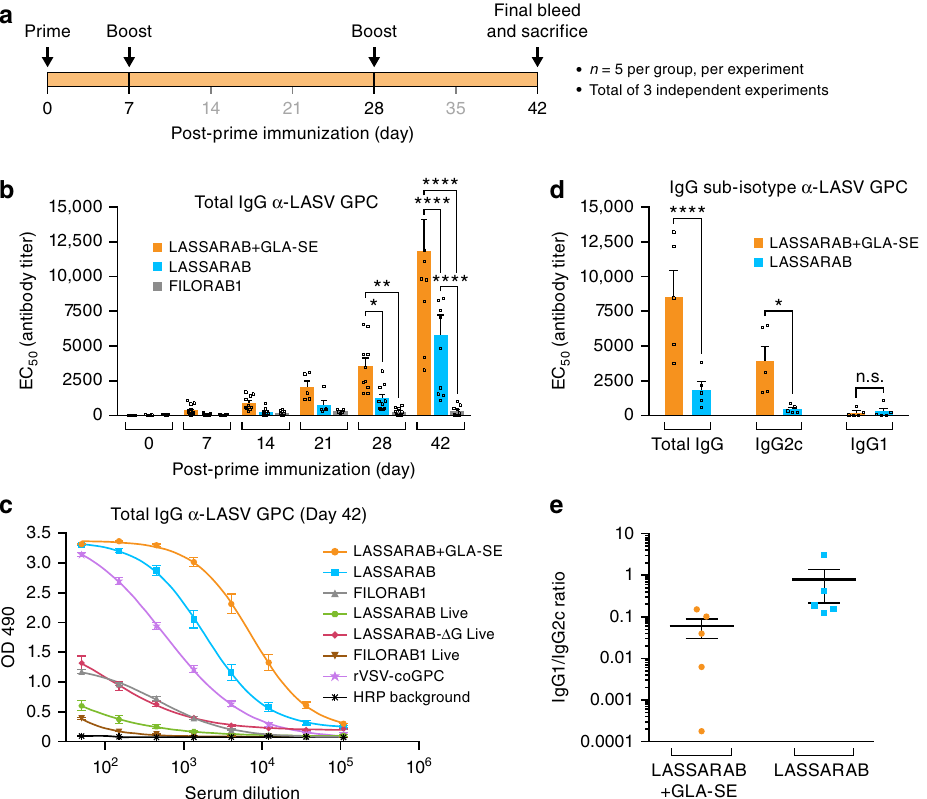
Fig. 4 Analysis of the humoral response towards Lassa virus glycoprotein. C57BL/6 mice were immunized IM in the gastrocnemius muscle with either 10 μ g of β -propiolactone inactivated viral particles in PBS or adjuvanted with 5 μ g of GLA, a TLR-4 agonist formulated in 2% of stable emulsion (SE); LASSARAB + GLA-SE, LASSARAB, FILORAB1 groups) and boosted two times with the same amount on day 7 and 28 ( a ). Immunizations with replication- competent viruses were executed with a single time inoculation of 10 6 ffu or pfu virus IM in the gastrocnemius (rc-LASSARAB; rc-FILORAB1 groups and rVSV-GPC). b The EC 50 values (obtained from the 4PL regression ELISA curve) of the total IgG titers against LASV GPC are plotted since day 0 until day 42. Error bars are representative of the standard error mean (SEM) and is calculated from 15 mice per group. Statistical signi fi cance was calculated by using 2-way ANOVA – post-hoc Tukey ’ s Honest Signi fi cant Difference Test. c ELISA of total IgG against LASV GPC of all day 42 groups are shown for all immunized groups. ELISA curves are generated from 4PL regression. Error bars are representative of the SEM of OD 490 values ( fi ve mice per group, in triplicates). d Day 35 EC 50 antibody titer of IgG sub-isotype (IgG2c and IgG1) against LASV GPC of sera from LASSARAB + GLA-SE and LASSARAB group was analyzed. Error bars are the SEM of a total of fi ve mice per group and statistical signi fi cance by 2-way ANOVA (post-hoc Tukey ’ s Honest Signi fi cant Difference Test). e The ratios of the respective EC 50 antibody titers IgG1/IgG2c are plotted and the F test was applied to check for variance difference ( p < 0.001). (**** P < 0.0001; *** P < 0.001; ** P < 0.01; * P <